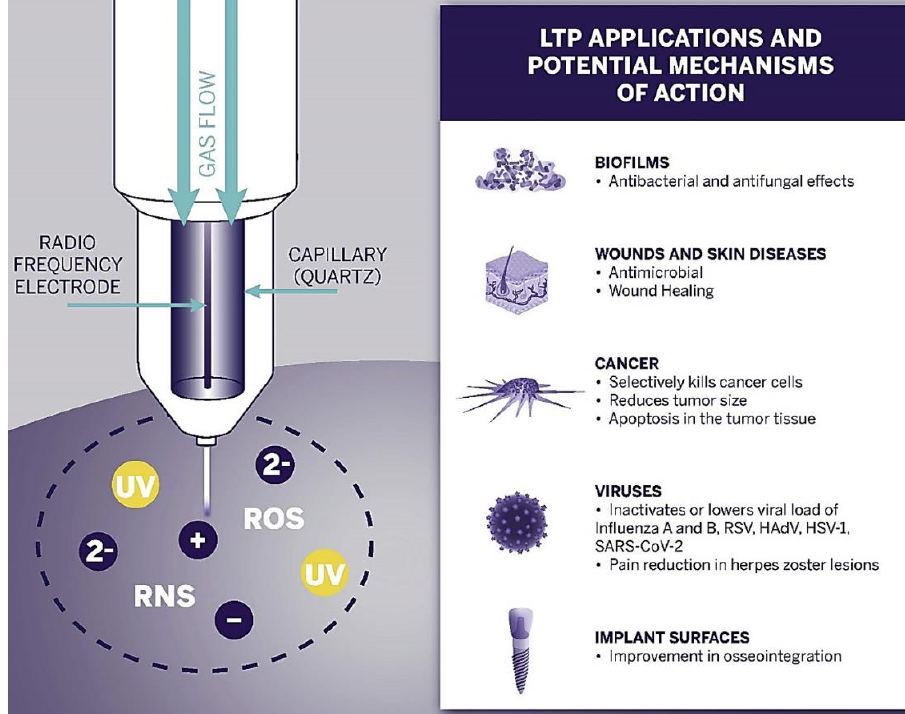
Figure 4. Schematic diagram of the LTP application spectrum and observed effects in biofilms, wound, skin, cancer, and viruses, as well as implant surface treatment [166]. wound, skin, cancer, and viruses, as well as implant surface treatment